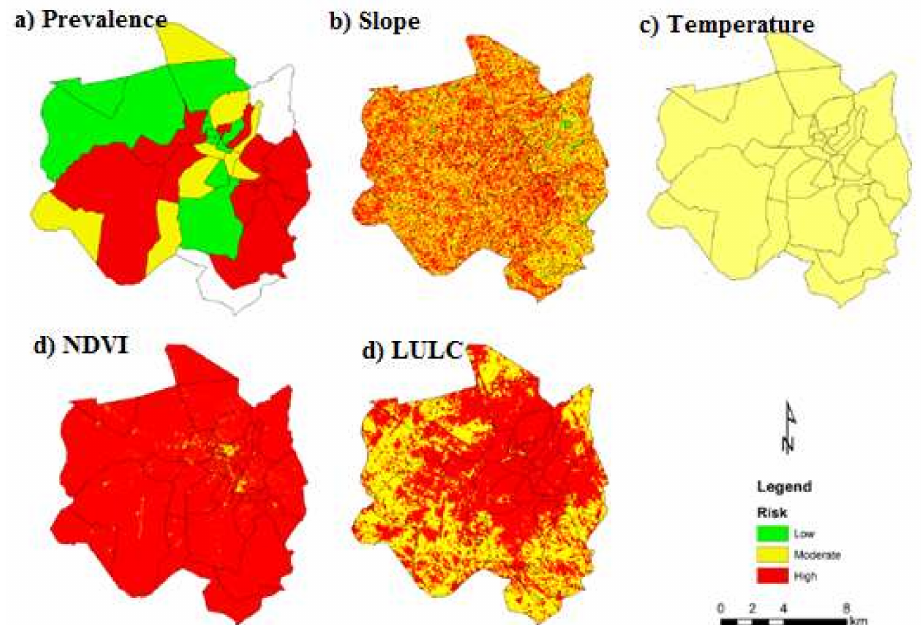
Figure 3. Risk for malaria occurrence. ( a ) Prevalence; ( b ) slope; ( c ) temperature; ( d ) NDVI; ( e ) LULC.